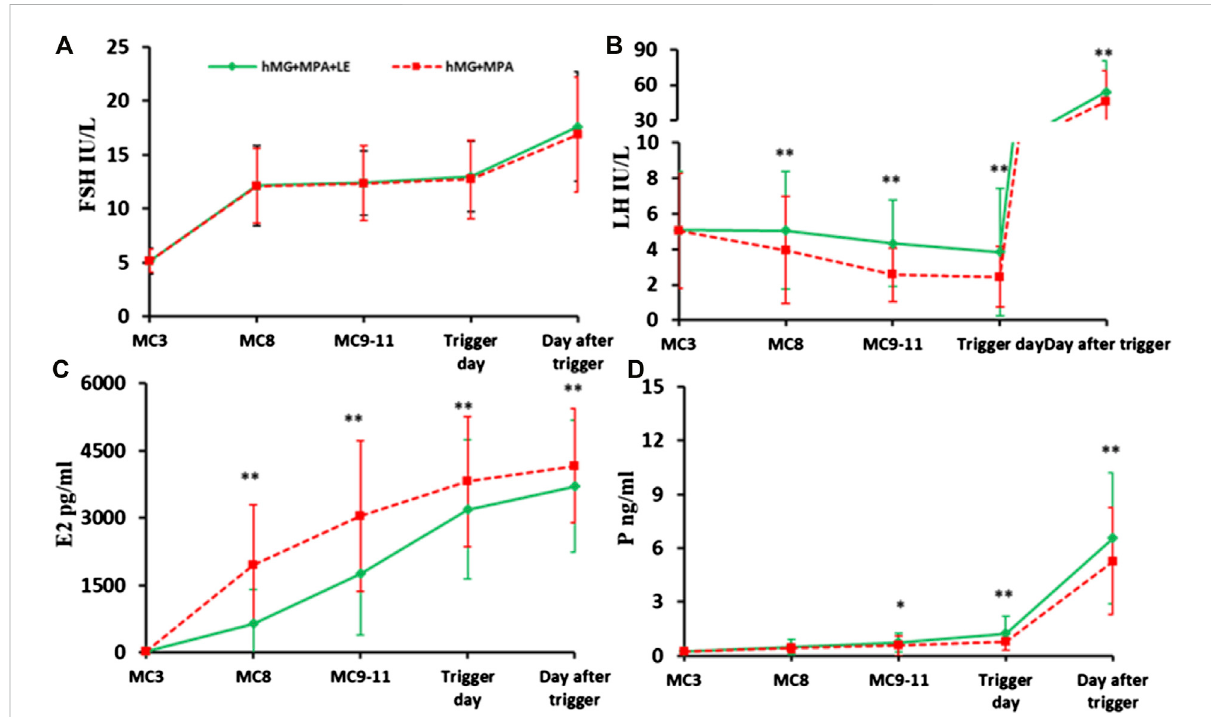
FIGURE 2 The dynamic changes in hormones during ovarian stimulation in the two groups. (A) . Serum FSH levels in the two groups during the COS; (B) . Serum LH concentration in the two groups during the COS; (C) . Serum E2 level between the two groups during the COS; (D) . Serum P levels in the two groups during the COS. The solid green lines represent the study group (hMG + MPA + LE) and the dotted red lines represent the control group (hMG + MPA). The asterisks de-note signi fi cant changes in hormone levels at the indicated time points (* p < 0.05, ** p < 0.01).